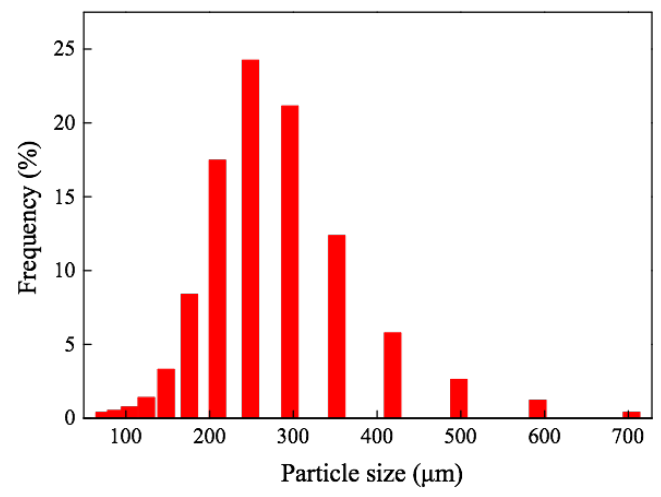
Figure 5. The size distribution of sand in the sand bed.